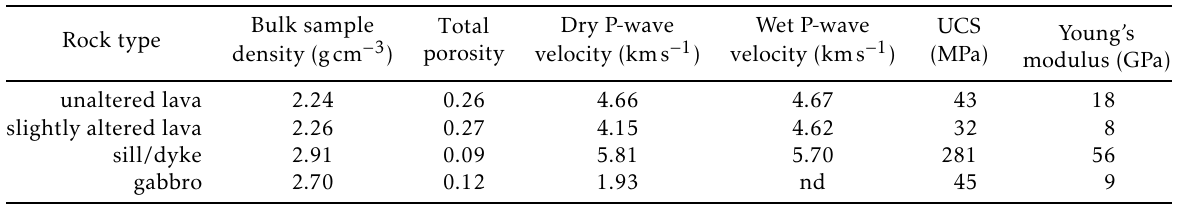
Table 1: Median values of the petrophysical properties of Piton de la Fournaise rocks. UCS = uniaxial compressive